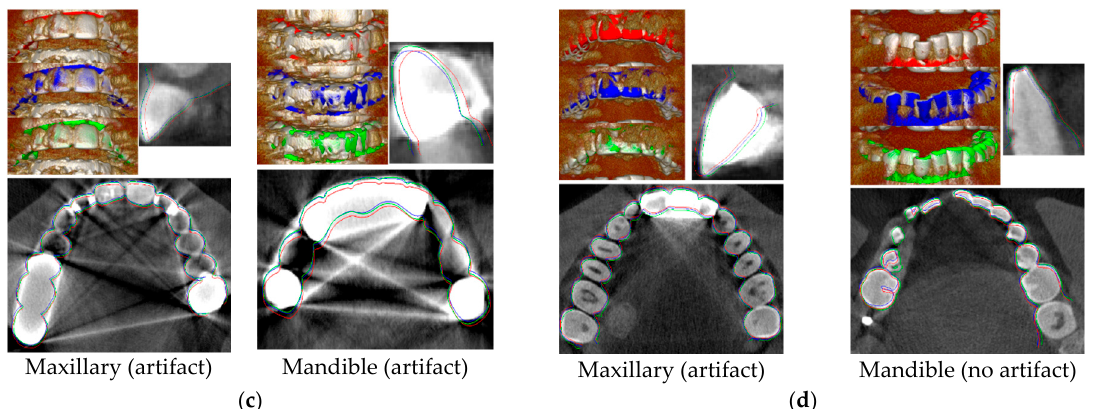
Figure 9. Modified iterative closest point (MICP) registration result. ( a ) Set no.1; ( b ) Set no.2; ( c ) Set no.3; ( d ) Set no. 4.